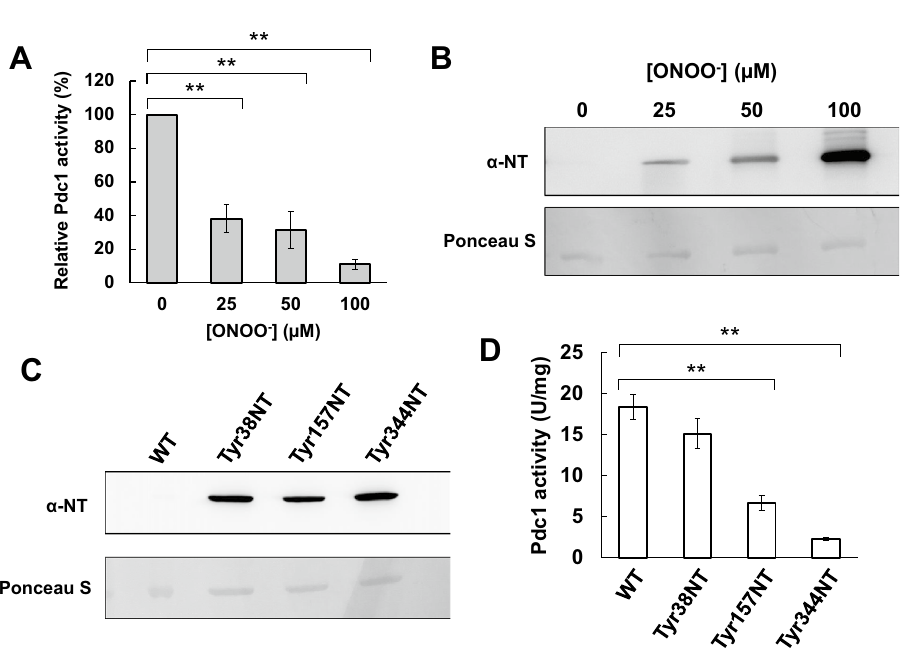
Figure 3. Effect of the PTN modification of Pdc1 on its enzymatic activity. ( A ) The enzymatic activity of recombinant WT-Pdc1 treated with the indicated concentration of ONOO - was measured. The values are the averages and standard deviations from three independent experiments. ( B ) Immunoblotting of WT-Pdc1 treated with various concentrations of ONOO - using anti-NT antibody was shown. The membrane was stained with Ponceau S to confirm the unified protein loaded. ( C ) Incorporation of NT into the recombinant Pdc1 prepared the heterologous expression system in E. coli was examined by western blotting with anti-NT antibody. The staining with Ponceau S was used for a loading control. ( D ) The enzymatic activity of WT-, Tyr38NT-, Tyr157NT-, or Tyr344NT-Pdc1 was measured. The values represent the averages and standard deviations from three independent experiments. ** ρ < 0.01 by Student’s t